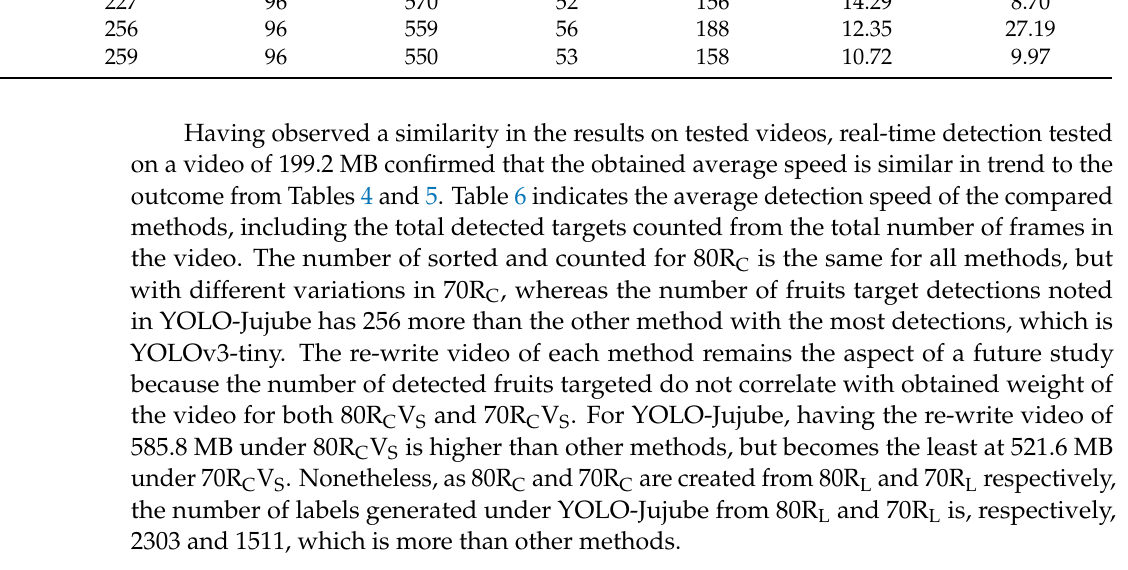
Table 6. Re-write video: Sorting and counting on 199.2MB